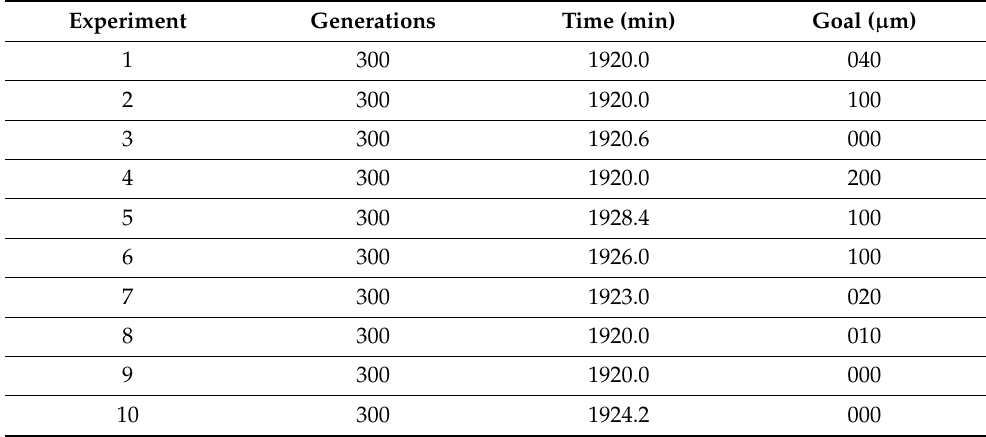
Table 4. Time and goal results.